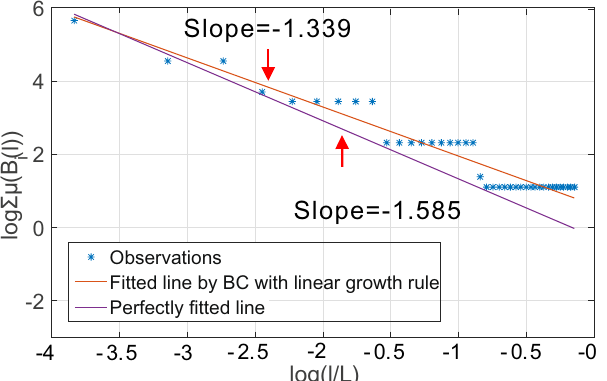
Figure 3. Observation of staircase effect in determination of dominant fractal dimension of G 4 of Sierpinski fractal network family using box-covering method with an incompatible linear growth rule.